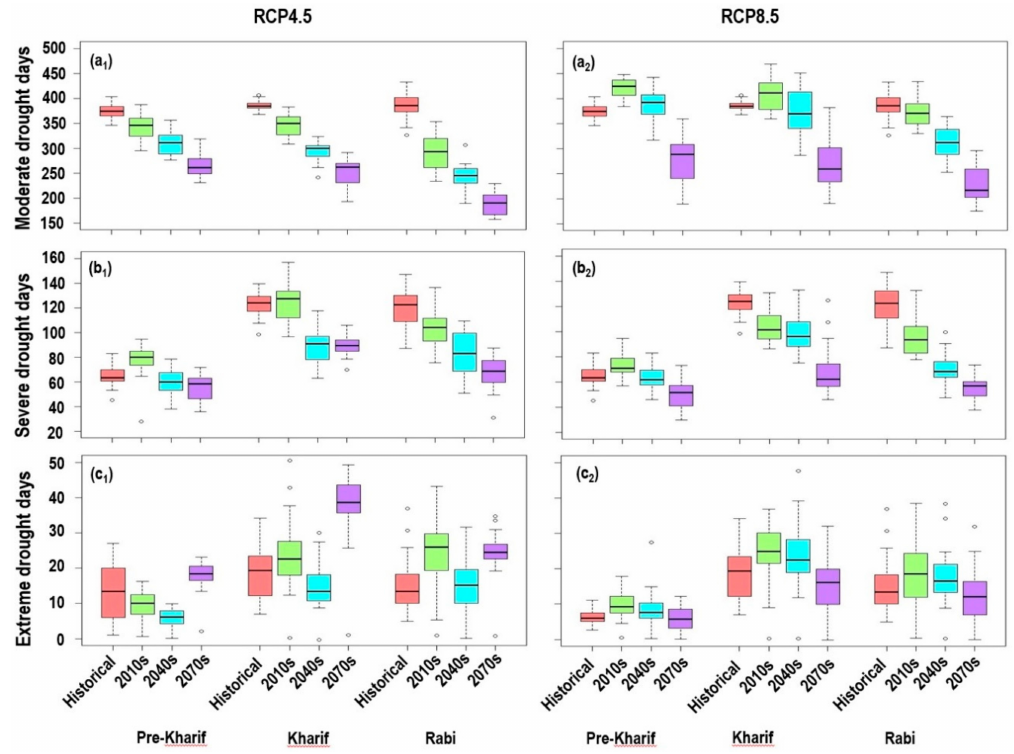
Figure 12. Future changes in seasonal drought days under RCP4.5 (left) and RCP8.5 (right); ( a ) moderate, ( b ) severe, and ( c ) extreme